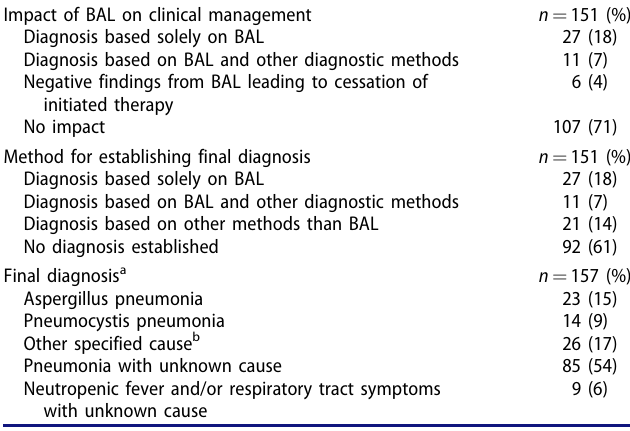
Table 1. Patient characteristics. Table 2. Impact on diagnosis and clinical management.